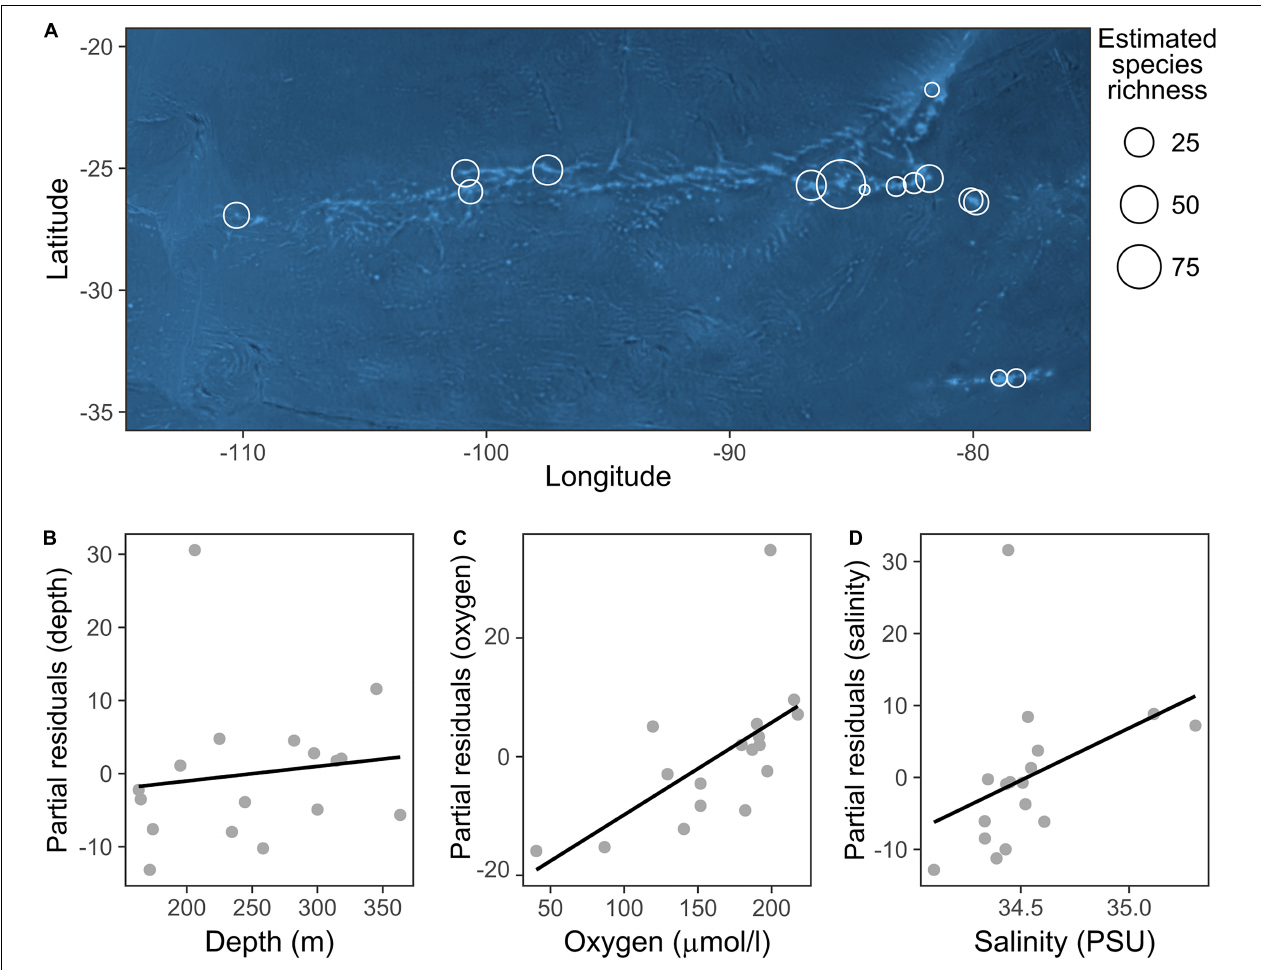
FIGURE 4 | (A) Distribution of echinoderm OTUs richness across sites. Taxa richness at each site was extrapolated by applying asymptotic diversity estimates of sampling curves (see section “Data Analysis”). Bubble size is proportional to the OTUs richness at each station. (B–D) Partial residual plots depicting the results of the generalized linear model (GLM) analyzing the relationship between environmental variables and echinoderm OTUs richness. This plot illustrates the positive effect of each predictor while controlling the effects of others.